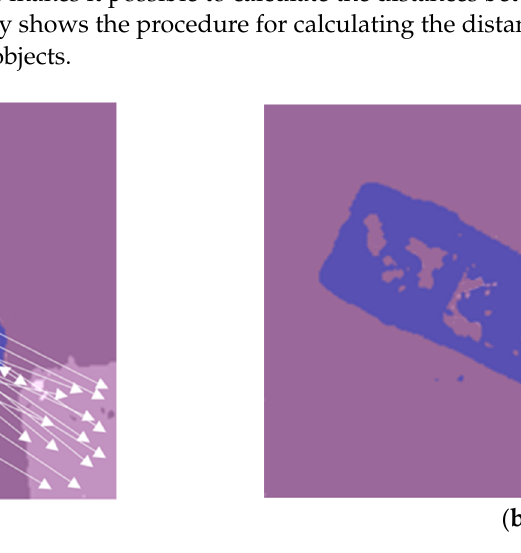
Figure 11. Automatic calculation of distances between objects: ( a ) distances between pixels belonging to different classes (only 15 distances are shown for readability); ( b ) minimum distance. The white arrows illustrate the distances between pixels belonging to different classes.